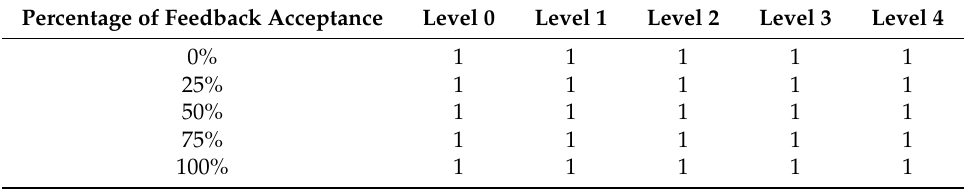
Table 1. User trust levels concerning autonomy when the devices do not make mistakes.